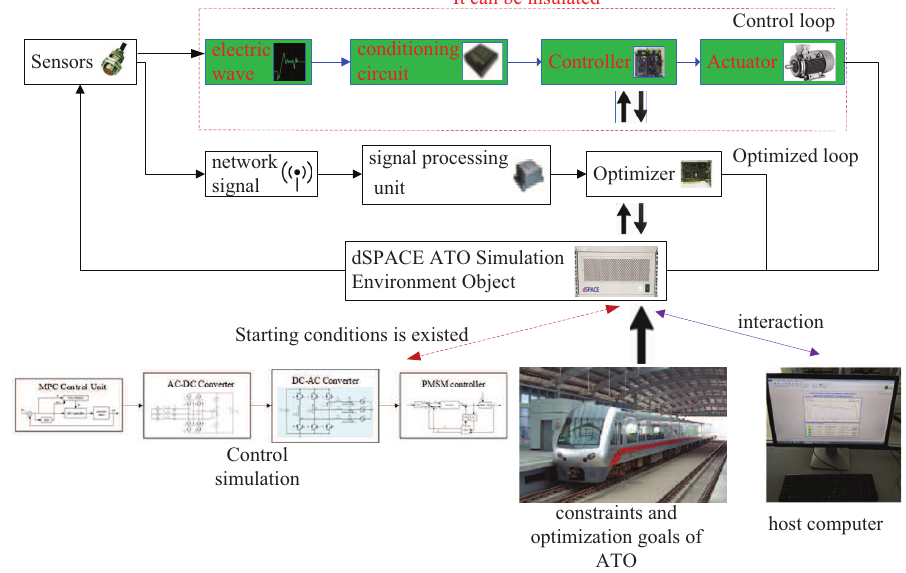
Figure 17. The structure diagram of automatic train operation (ATO) hardware-in-the-loop simulation (HILS) platform.